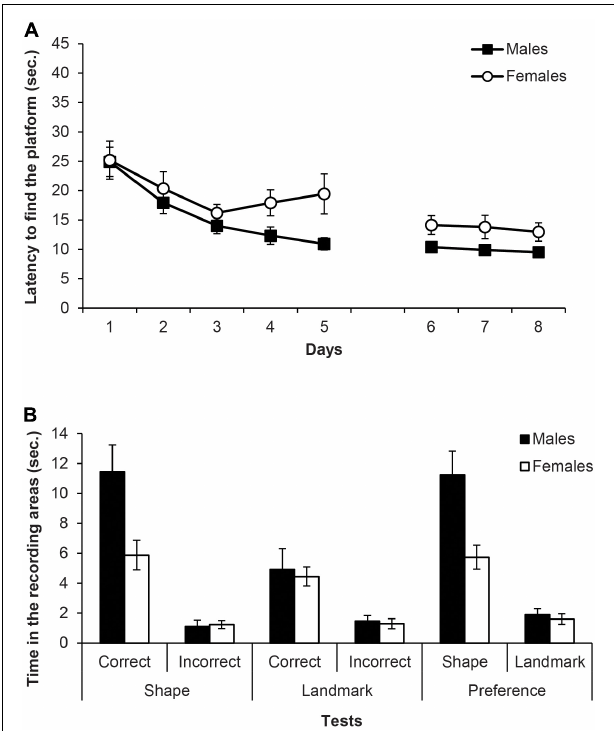
FIGURE 5 | Experiment 2B. (A) Mean escape latencies by the subjects in Experiment 2B during the three training phases and the escape trials of the test days. Error bars denote standard error of the mean. (B) Mean time spent by the subjects in Experiment 2B in the two recording areas during the main test trials: Shape test and Landmark test (recording areas: correct and incorrect, C and I, respectively), and Preference test (recording areas: shape and landmark, S and L, respectively). Error bars denote standard error of